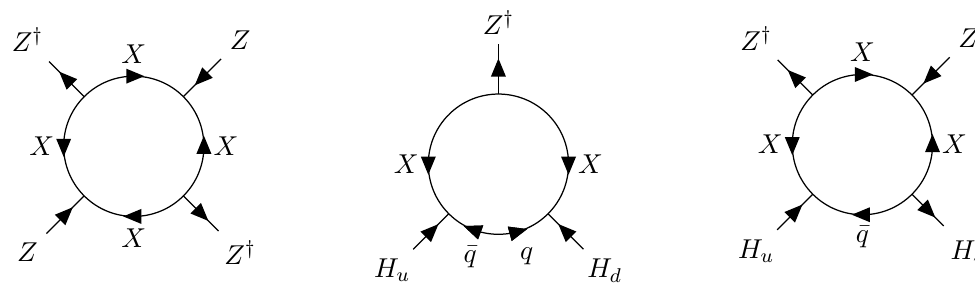
Figure 6. The Feynman diagrams in the UV model which generate the Higgs mass